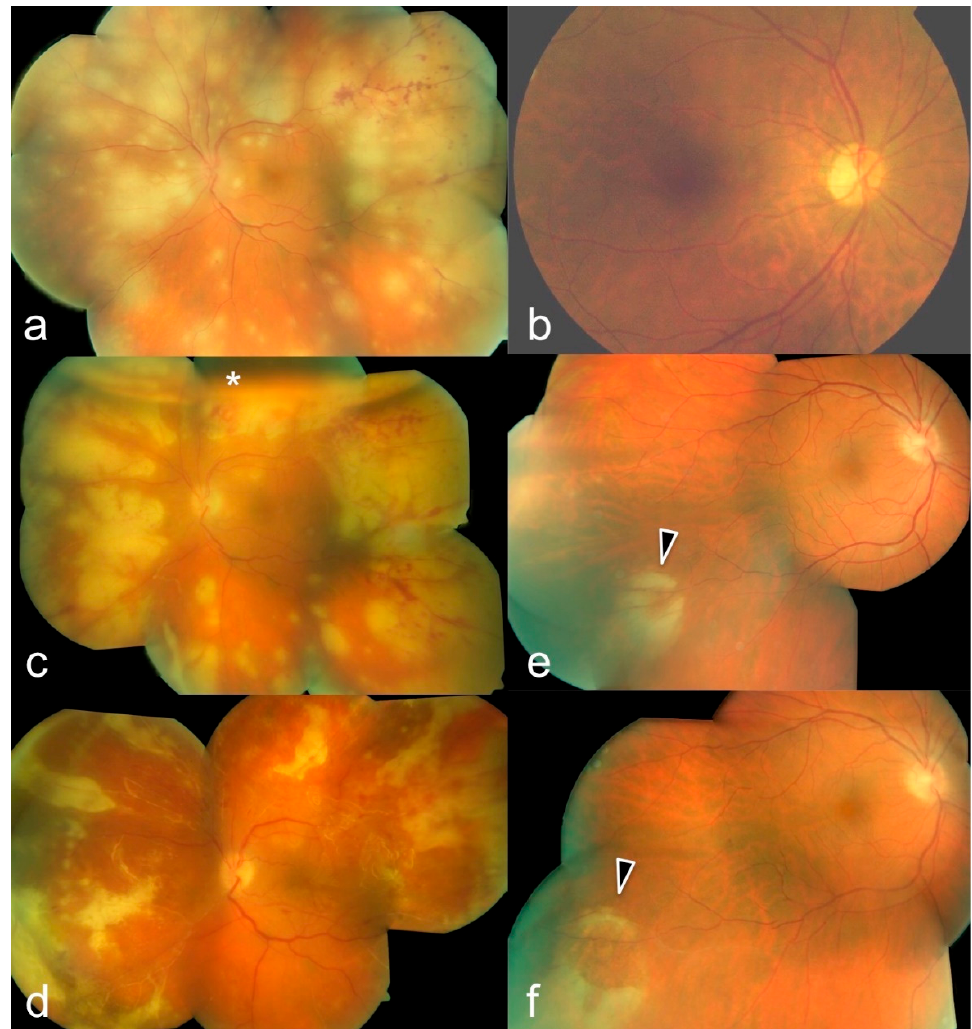
Figure 2. 59-year-old patient with acute retinal necrosis (ARN) in the left eye: first presentation with suspected retinal branch artery occlusion and iritis treated with topical prednisolone for about 10 days and “non improving vision”. ( a ) Fundus photography of the left eye. Visual acuity 0.5; conjunctiva injected, anterior chamber cells +, Arlt’s triangle with pattern of mutton-fat keratic precipitates, retina with circular whitish foci and hemorrhages, especially localized temporally. ( b ) The right eye was not affected. Treatment including vitrectomy, intravitreal ganciclovir, and air (asterisk) ( c ) followed by detection of varizella zoster virus (VZV) using polymerase chain reaction (PCR) and parenteral aciclovir treatment (10 mg/kg of body weight every 8 h + prednisolone and two ganciclovir intravitreal injections. Ten days later, retinal detachment occurred and was treated with vitrectomy, ganciclovir injection, and silicone oil tamponade. The retina was stable postoperatively, and the visual acuity was 0.2 ( d ). Four weeks after the onset of the ARN in the left eye, the right eye achieved a visual acuity of 1.0, but showed a temporal fresh necrotic focus ( e , arrowhead). Immediate start with intravitreal Ganciclovir. Follow-up 10 days later with a clearly demarcated infiltrate ( f ) followed by weekly checkups and long-term treatment with 800 mg Aciclovir five times a day. For further details see Table 1, Patient 4.